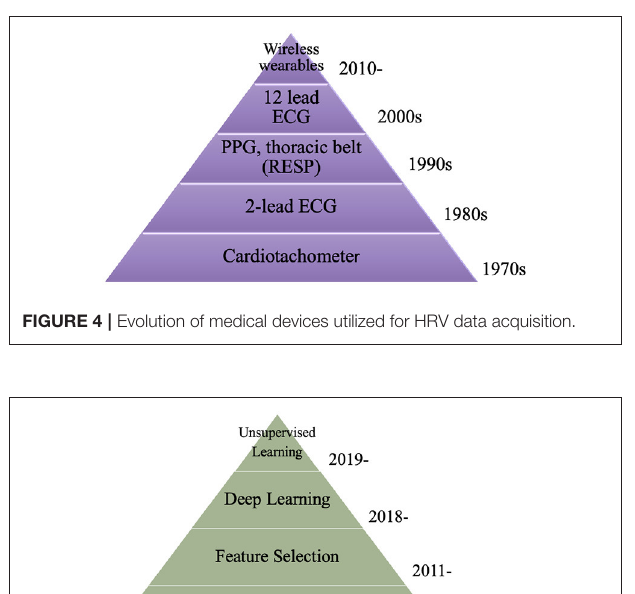
Figure 4 delineates the evolution of healthcare devices used to